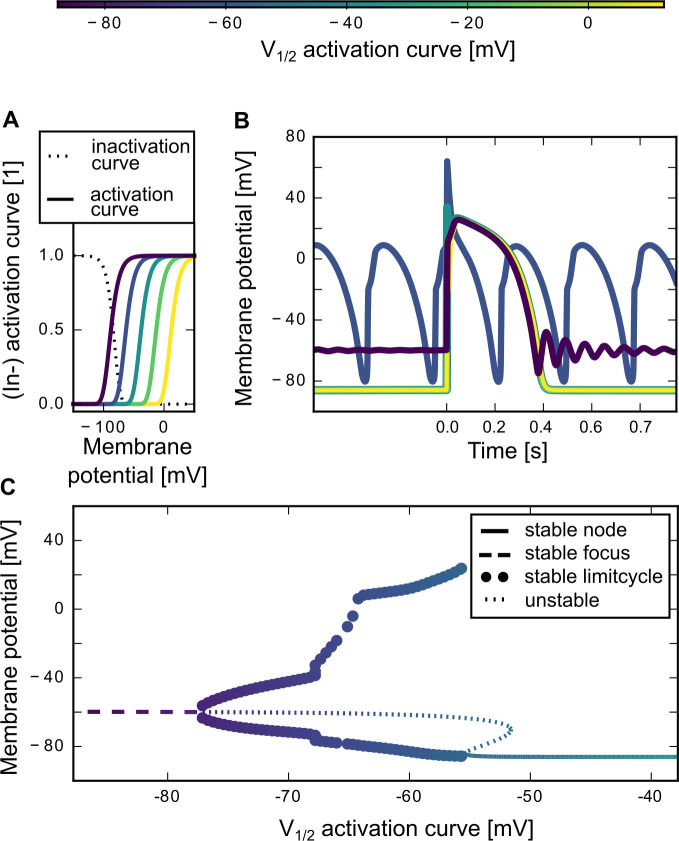
Shifting the sodium channel activation curve.(A) We shifted the midpoint voltage (V1/2) of the sodium channel activation curve from its original value at -37.8 mV in both directions: +50 mV to more positive and -50 mV to more negative voltages. The sodium channel inactivation curve remained unchanged. The activation and inactivation curves were based on the steady state values of the sodium activation and inactivation gate variables m, h and j (activation curve = m∞3, inactivation curve = h∞j∞). (B) Every shift of the sodium channel activation curve changed the cardiac action potential shape. The colors match the corresponding activation curve in A. The plot shows a part of a simulation with a 2 ms stimulation pulse of 60 pA/pF amplitude. The system was given 1 s to settle onto the resting potential before the pulse started at timepoint zero. (C) Bifurcation diagram which shows the resting potential of the system for negative shifts (-50 mV to 0 mV) in the midpoint voltage of the sodium activation curve. The linecolor matches the corresponding midpoint of the activation curve (x-axis), similar to the colorbar shown in the Fig and the color code of A and B.